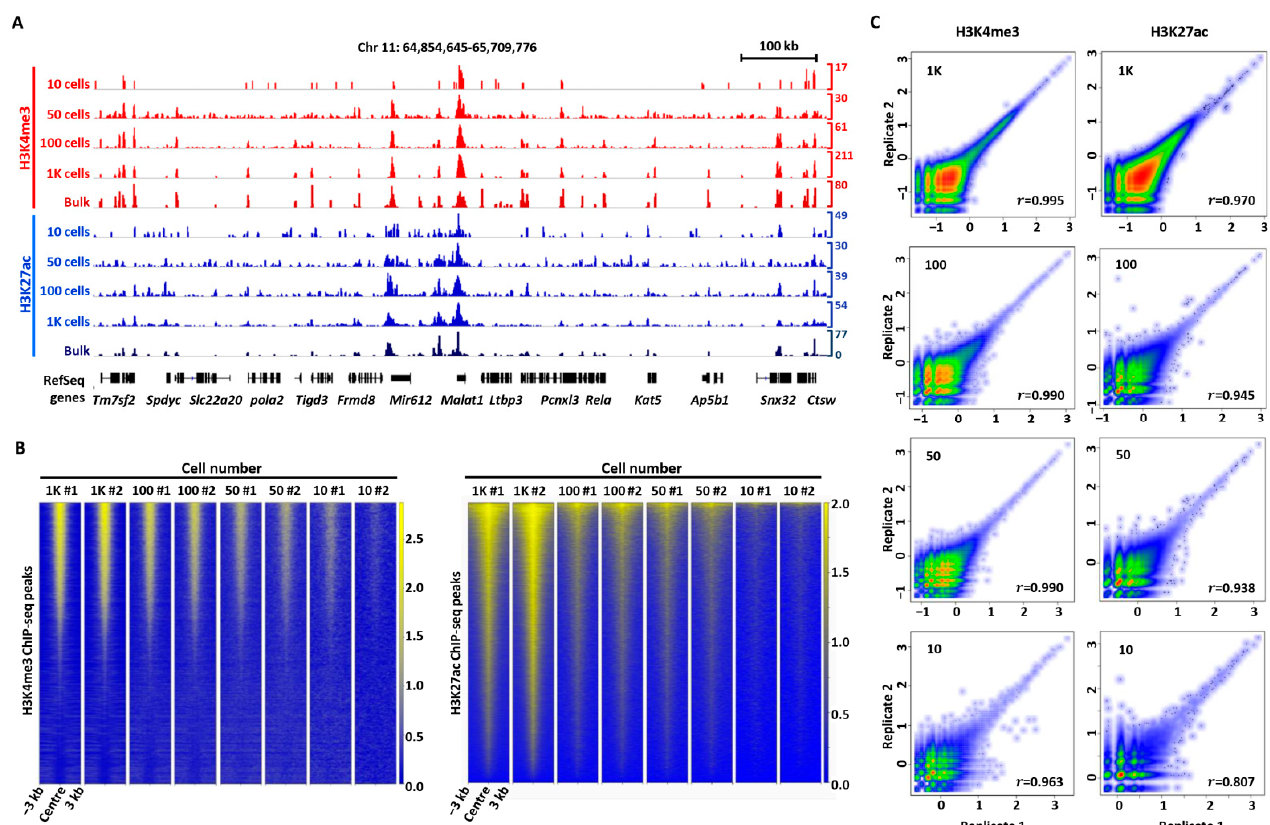
Figure 2. 2cChIP-seq reliably generates H3K4me3 and H3K27ac profiles in small numbers of cells. ( A ) Normalized H3K4me3 and H3K27ac 2cChIP-seq signals at the indicated regions using data from various sample sizes. ENCODE data (H3K4me3, GSM2534289; H3K27ac, and GSM733656) are shown for comparison. ( B ) Heatmaps of 2cChIP-seq data for the indicated cell numbers. Data are centered on peaks called from GSM2534289 for H3K4me3 and GSM733656 for H3K27ac. A window of 6 kb ( − 3 kb to +3 kb) around the peak center is shown. ( C ) Scatter plot comparison of two 2cChIP-seq biological replicate datasets generated with various numbers of cells. The r indicates Pearson’s correlation coefficient calculated in non-overlapped 4-kb bins across the entire human genome. Sample size: n = 2. Chr, Chromosome. #1 and #2, represent two 2cChIP-seq